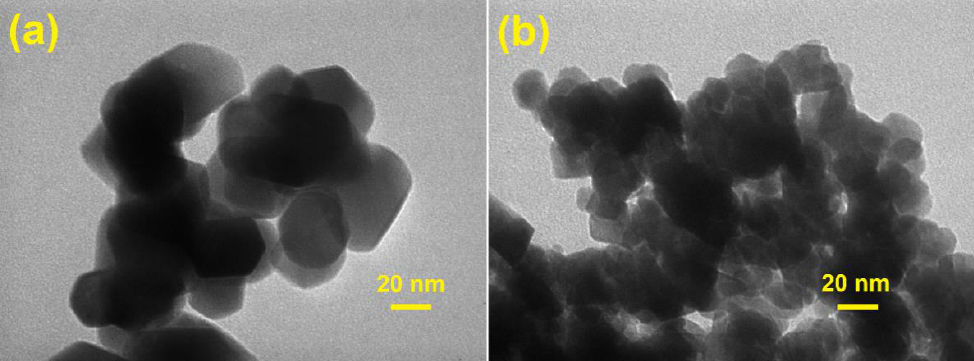
Figure 4. TEM of ZnNd x Fe 2−x O 4 nanoparticles: ( a ) x = 0; ( b ) x = 0.03.